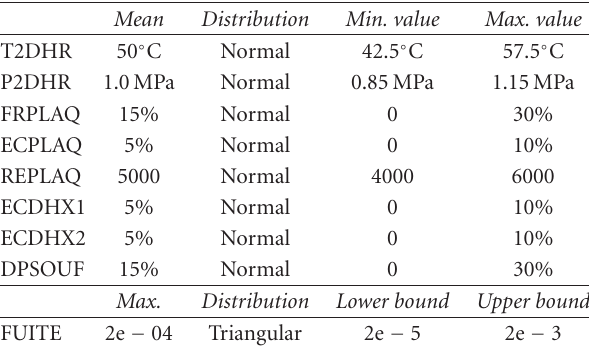
Table 1: Critical parameters distributions.